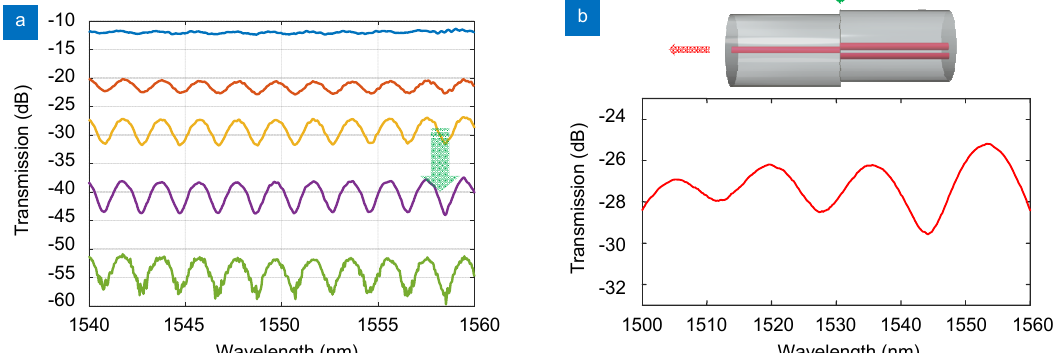
Fig. 6 | Schematic diagrams of two MCF in-line interferometers: the TCF interferometer in the structure of SMF-TCF-SMF and the corre- sponding output optical spectrum (a), the SCF in-line interferometer based on the structure of SMF-MMF-SCF-MMF-SMF (b).